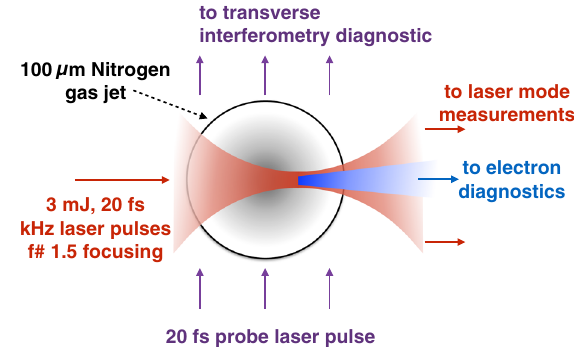
FIG. 1. Top view schematic of the experimental setup. A laser pulse is tightly focused into a gas jet. Strong focusing with a f #1 . 5 optics results in a short Rayleigh length compared to the gas jet length of 100 μ